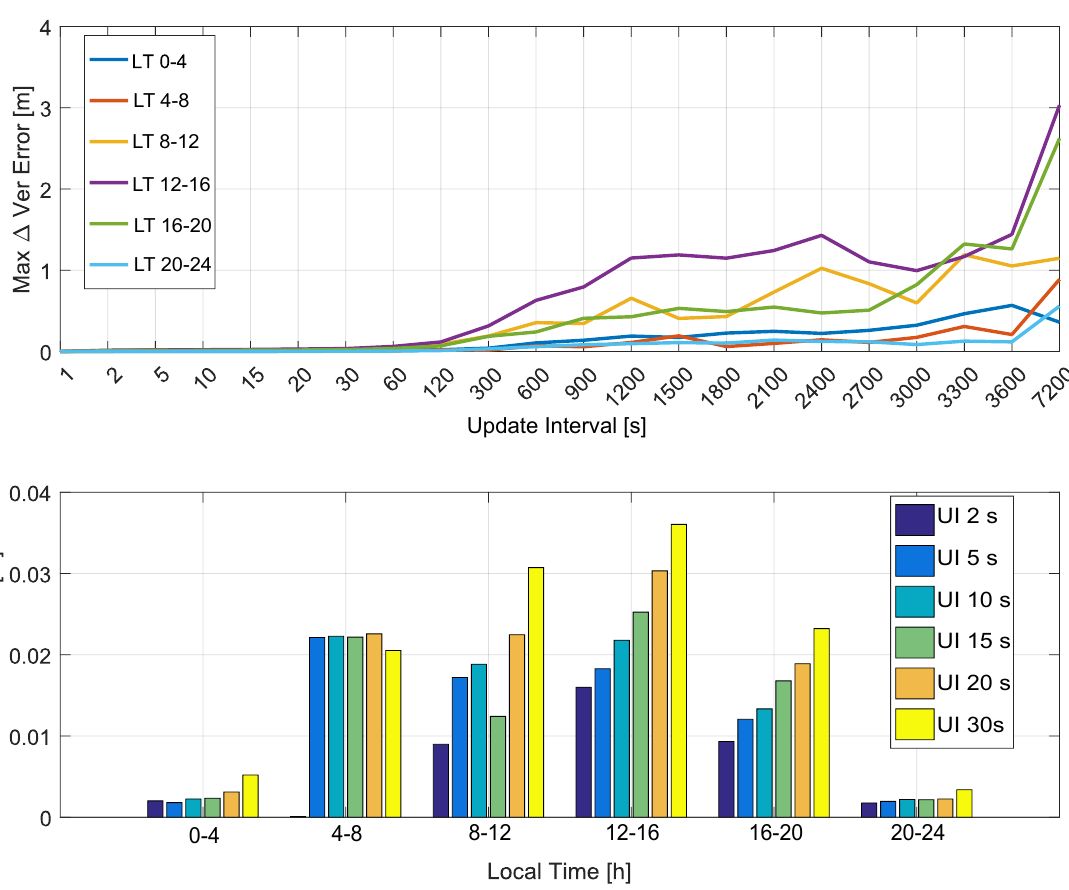
Figure 13. Maximum absolute vertical position differences as a function of the local time. In the legend, “UI” stands for “Update